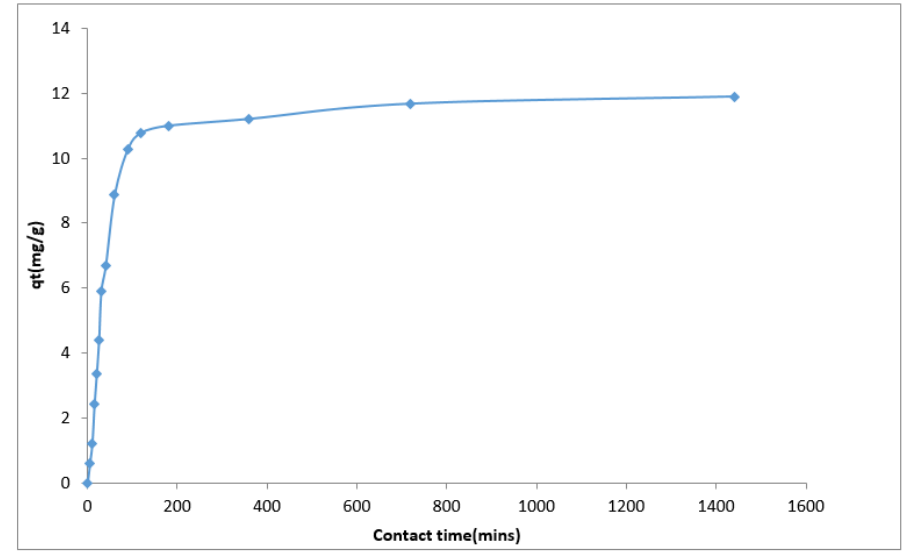
Figure 11. Effect of contact time on Cd(II) ion sorption on YTBS adsorbent.